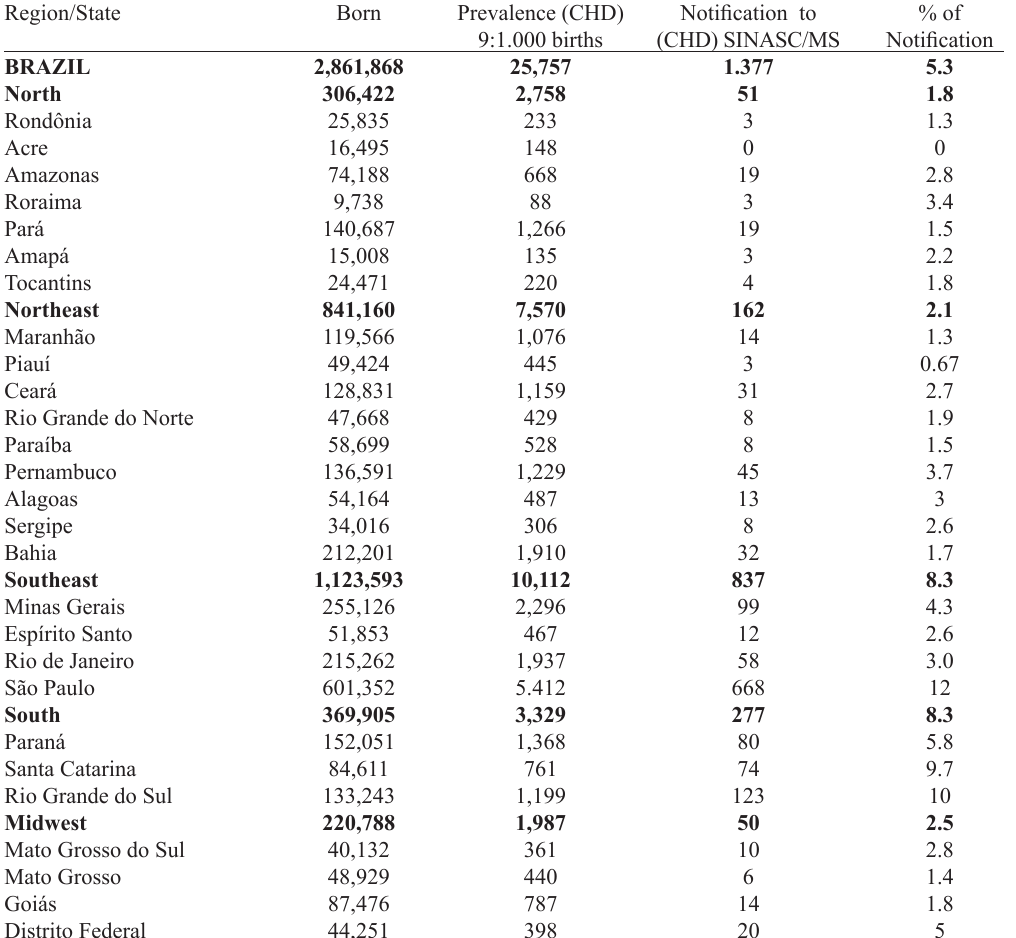
Table 1. Distribution of the number of births, prevalence of Congenital Heart Disease (CHD), birth notification with (CHD) - SINASC/Ministry of Health (MOH) and notification percentage for Brazil, regions and federated units in